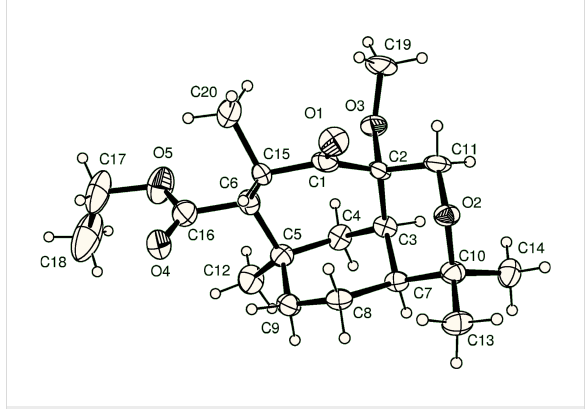
Figure 4: ORTEP diagram of compound 32 (30% probability ellips- oids).